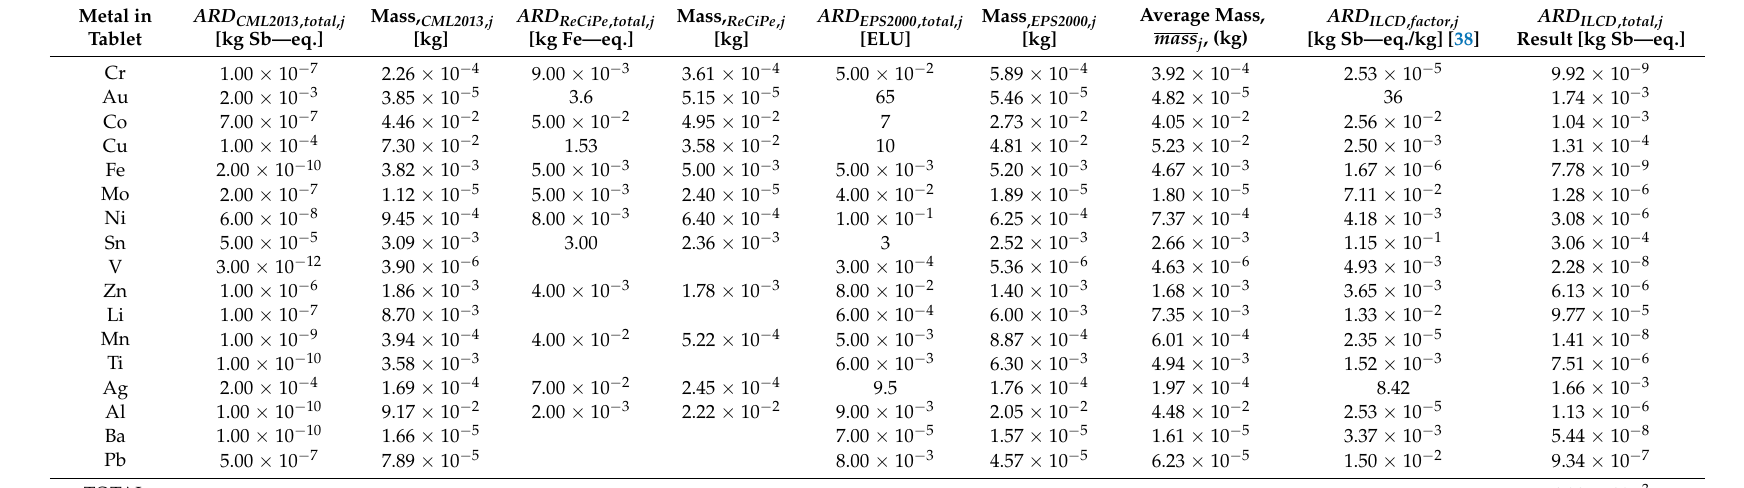
Table 3. Average masses of metals in the tablet [36] used in OLCA for ARDI